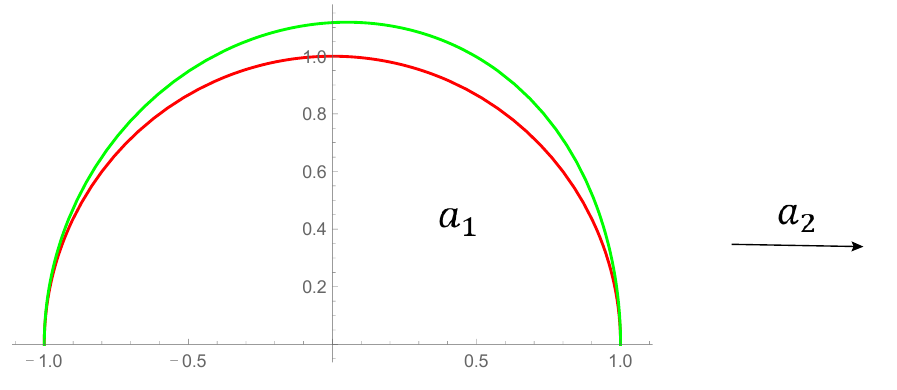
Figure 9 . The profile of the causal shadow in terms of the causal horizon (red) against the Q.E.S (green) in AdS , with ∆ = 2 . For illustration purpose we exaggerated the value of G 3 order